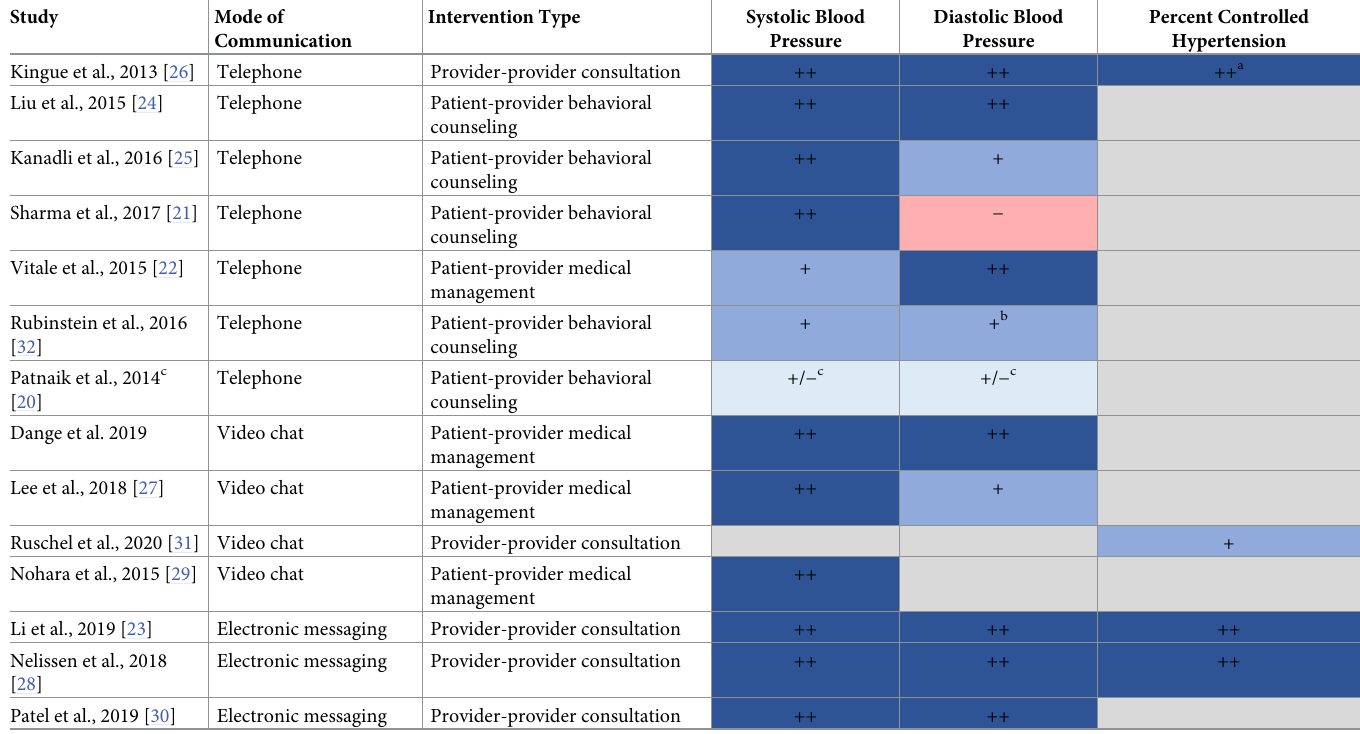
Table 3. Overview of outcomes for intervention studies (compared to control if included).